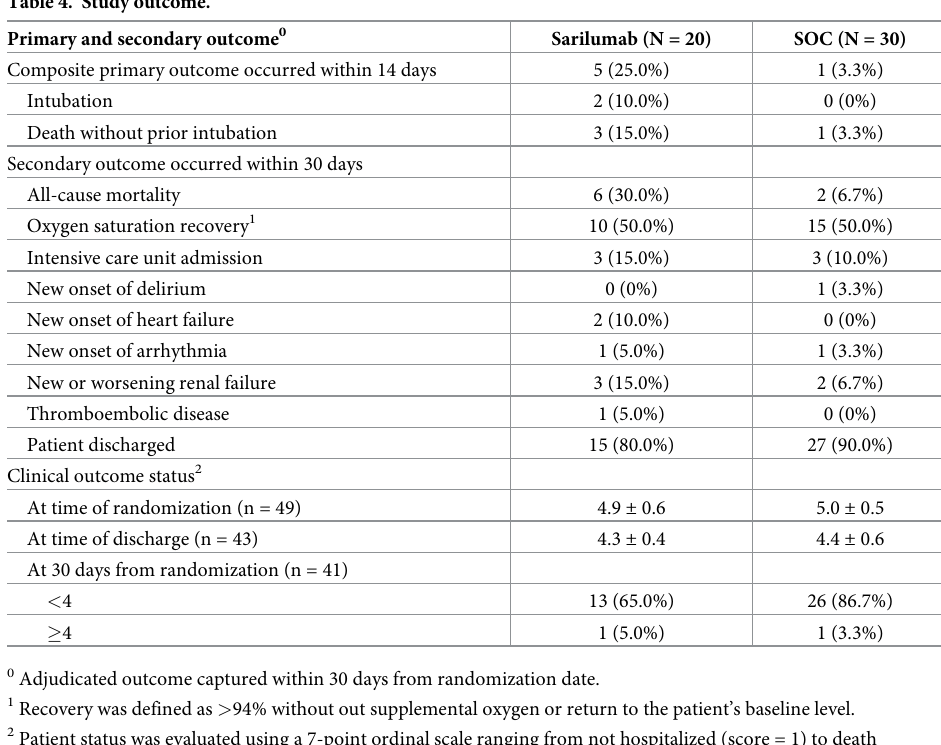
Table 4. Study outcome. Primary and secondary outcome